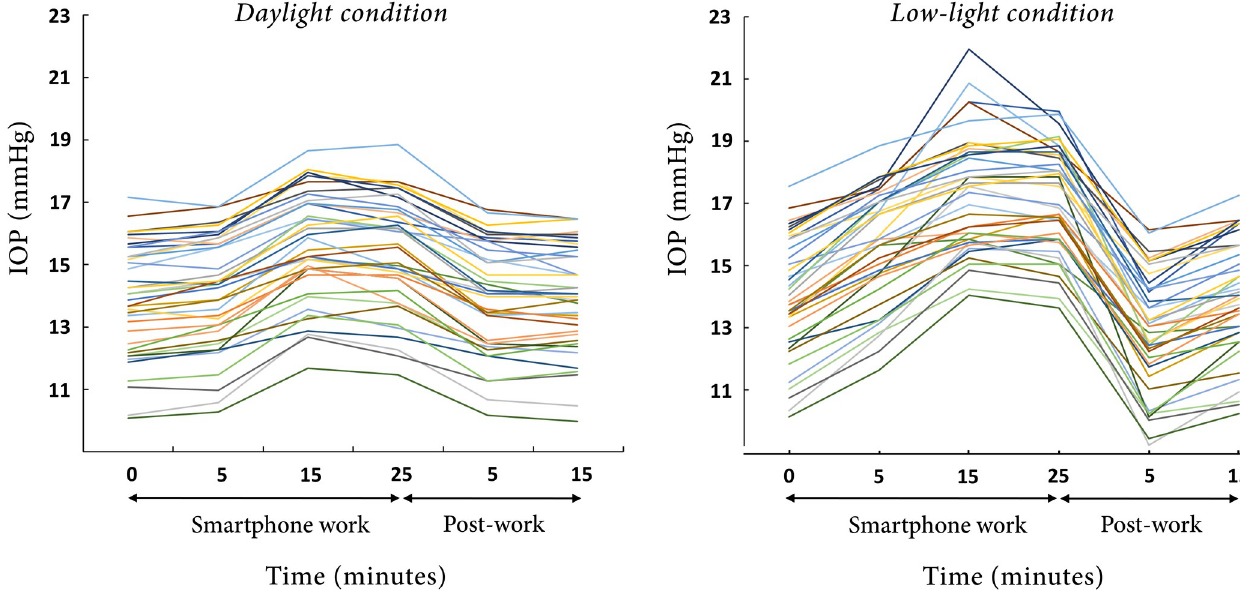
Fig 2. Graph depicting changes of intraocular pressure (IOP) among group of 39 eyes during and after smartphone work under daylight (A) and low- light (B) conditions. Note that the X-axis is not to scale but depicts the times at which the IOPs were measured during and after the smartphone work.